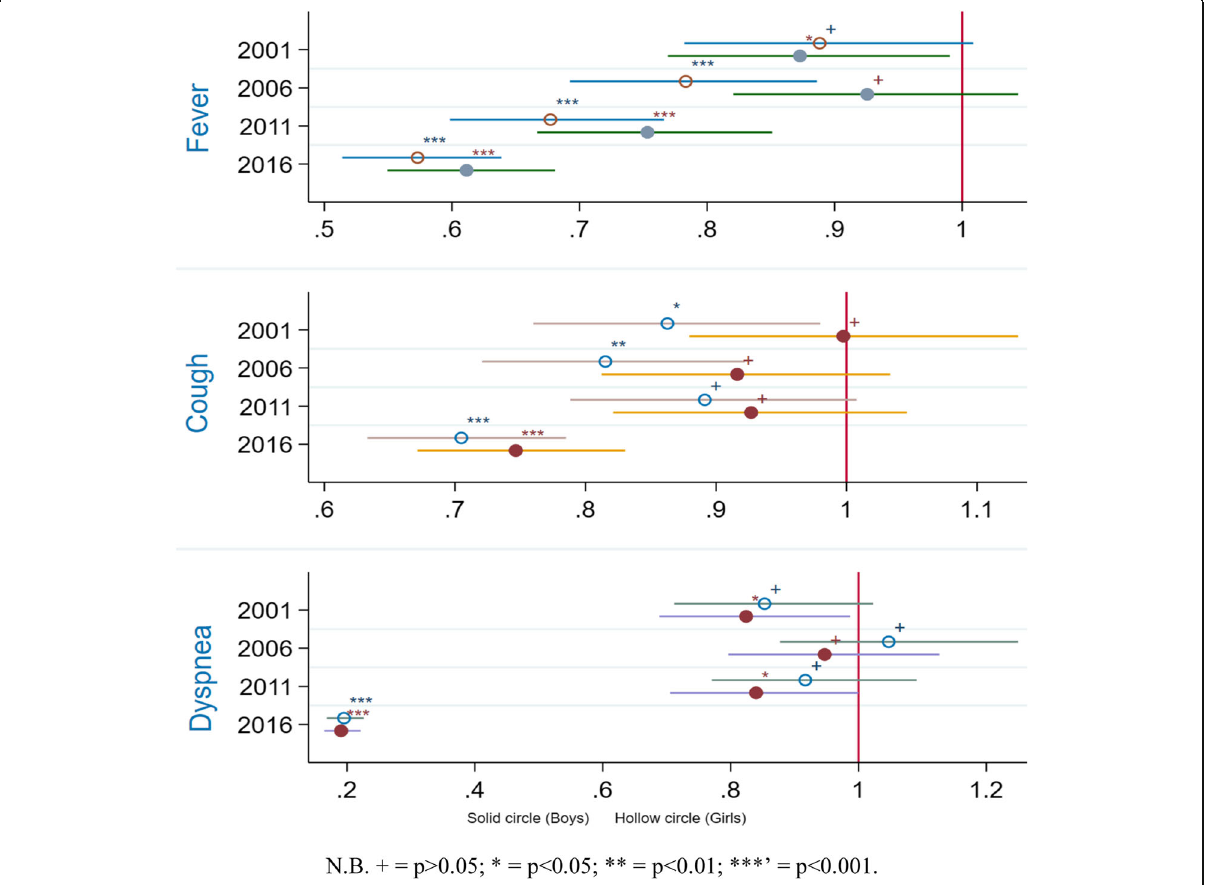
Fig. 3 Trends in the odds ratios of ARIs among Ugandan infants 1995 –